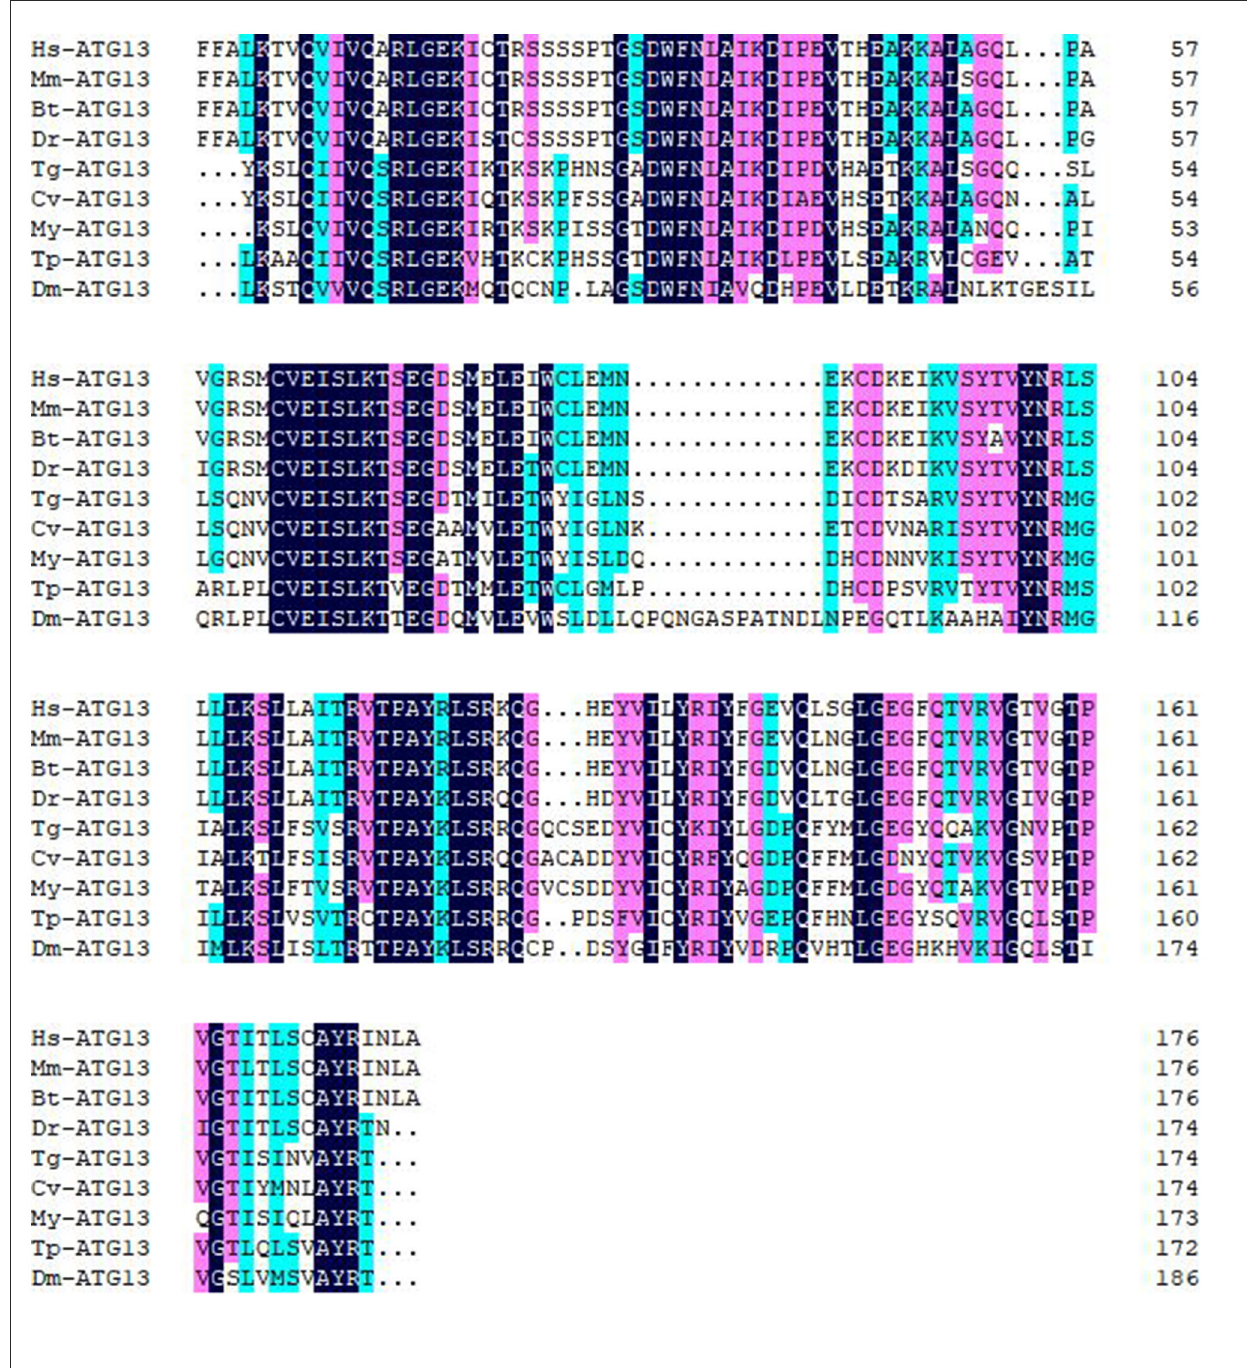
FIGURE2 Amino acid sequence alignment of ATG13 HORMA domains from blood clam and other species. Amino acid sequence alignment was performed ClustalW software. Hs, Homo sapiens ; Mm, Mus musculus ; Bt, Bos Taurus ; Dr, Danio rerio ; Tg, Tegillarca granosa ; Cv, Crassostrea virginica ;